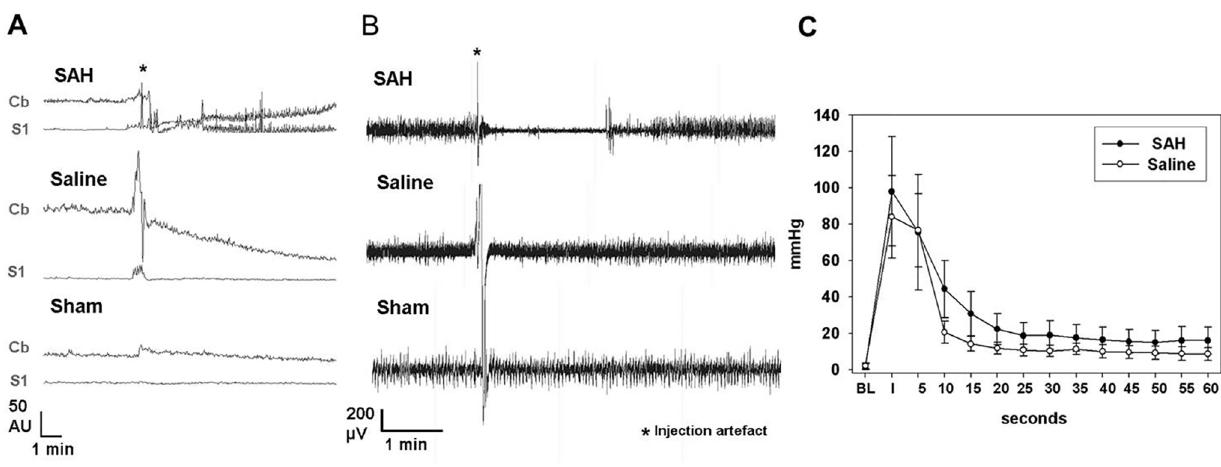
Fig. 2. Acute effects on perfusion, cortical signaling and ICP. A: sample traces of rCBF of the three experimental groups immediately after injection. B: sample ECoG traces of the three experimental groups immediately after injection. C: ICP in SAH and saline groups before, during and until 1 minute after injection. Curves of the two groups do not significantly differ from each other. Both groups display significant elevation from baseline in the first 20 seconds after injection in paired samples t-test. Interestingly, although no longer statistically significant, in both groups, ICP settles at a new plateau that is higher than baseline for the rest of the recording